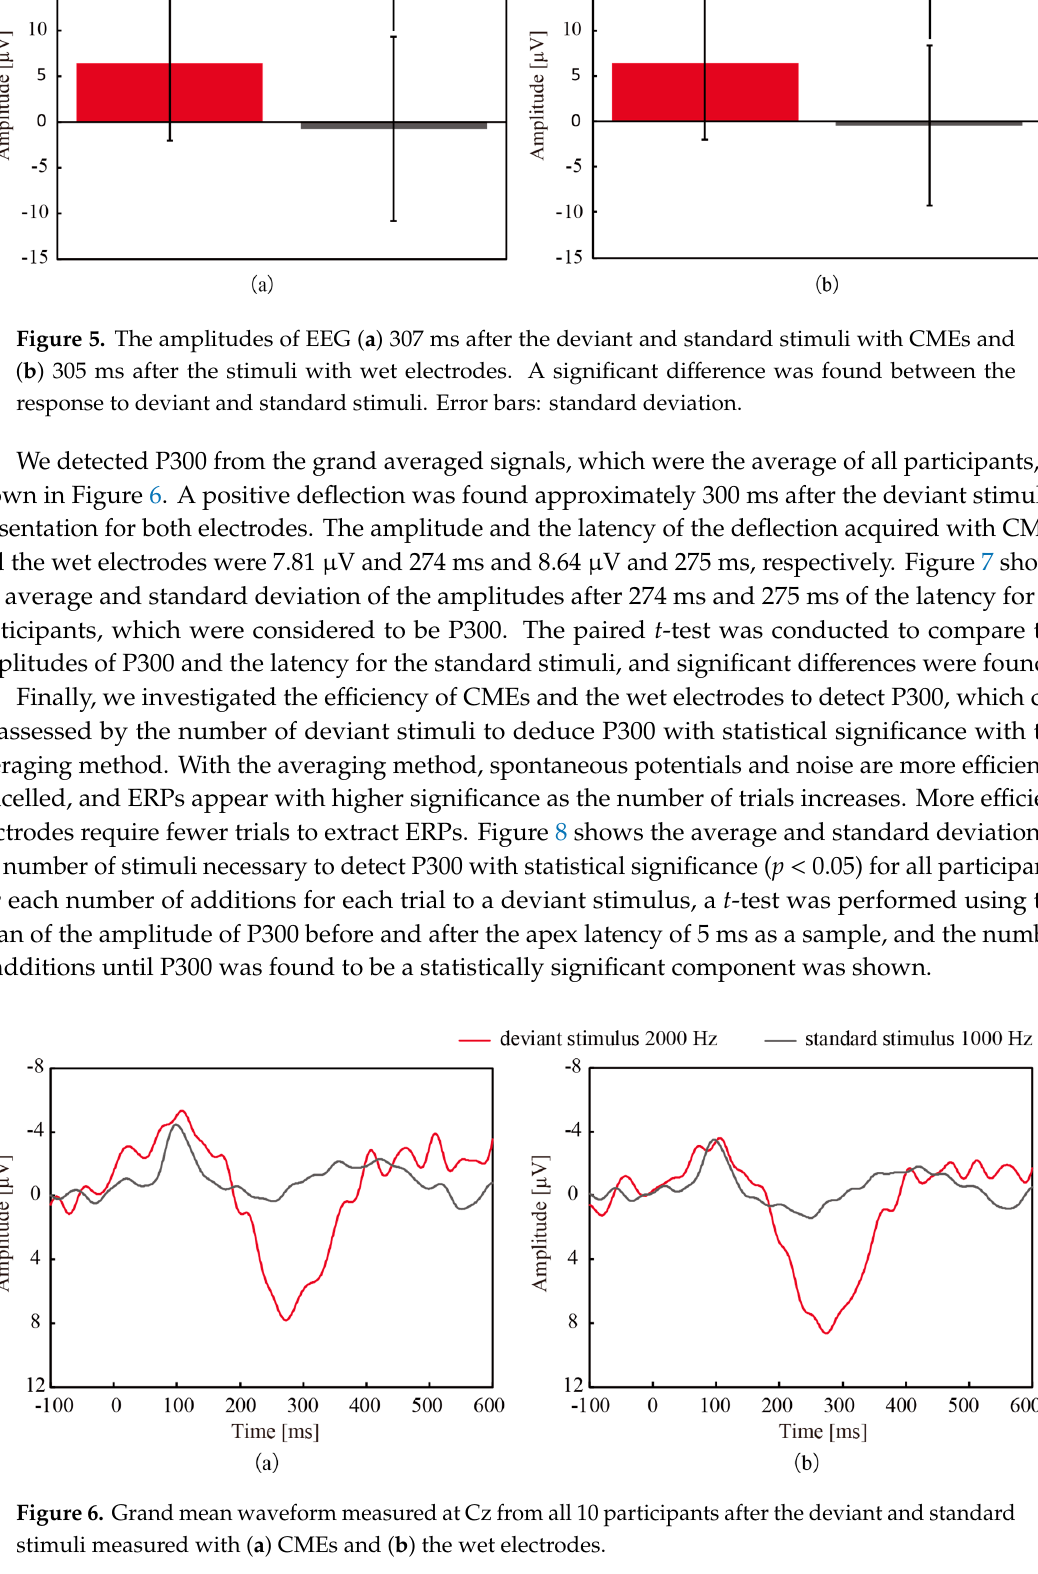
Figure 6. Grand mean waveform measured at Cz from all 10 participants after the deviant and standard stimuli measured with ( a ) CMEs and ( b ) the wet electrodes.